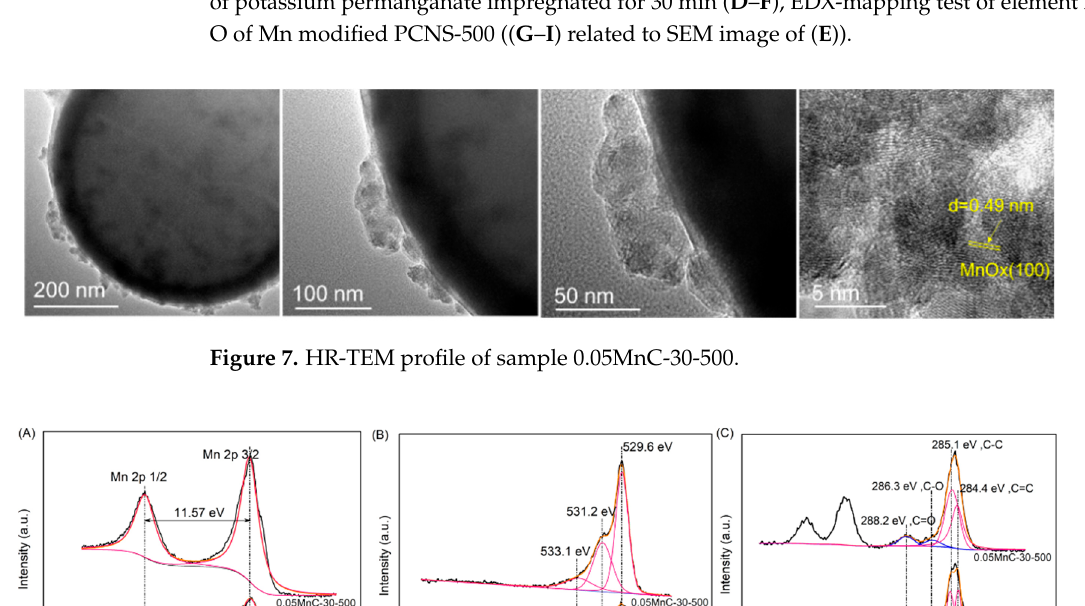
Figure 6. SEM images of PCNS-500 ( A – C ), SEM images of Mn modified PCNS-5000 with 0.05 mol/L of potassium permanganate impregnated for 30 min ( D – F ), EDX-mapping test of element Mn, C, and O of Mn modified PCNS-500 (( G – I ) related to SEM image of ( E )).